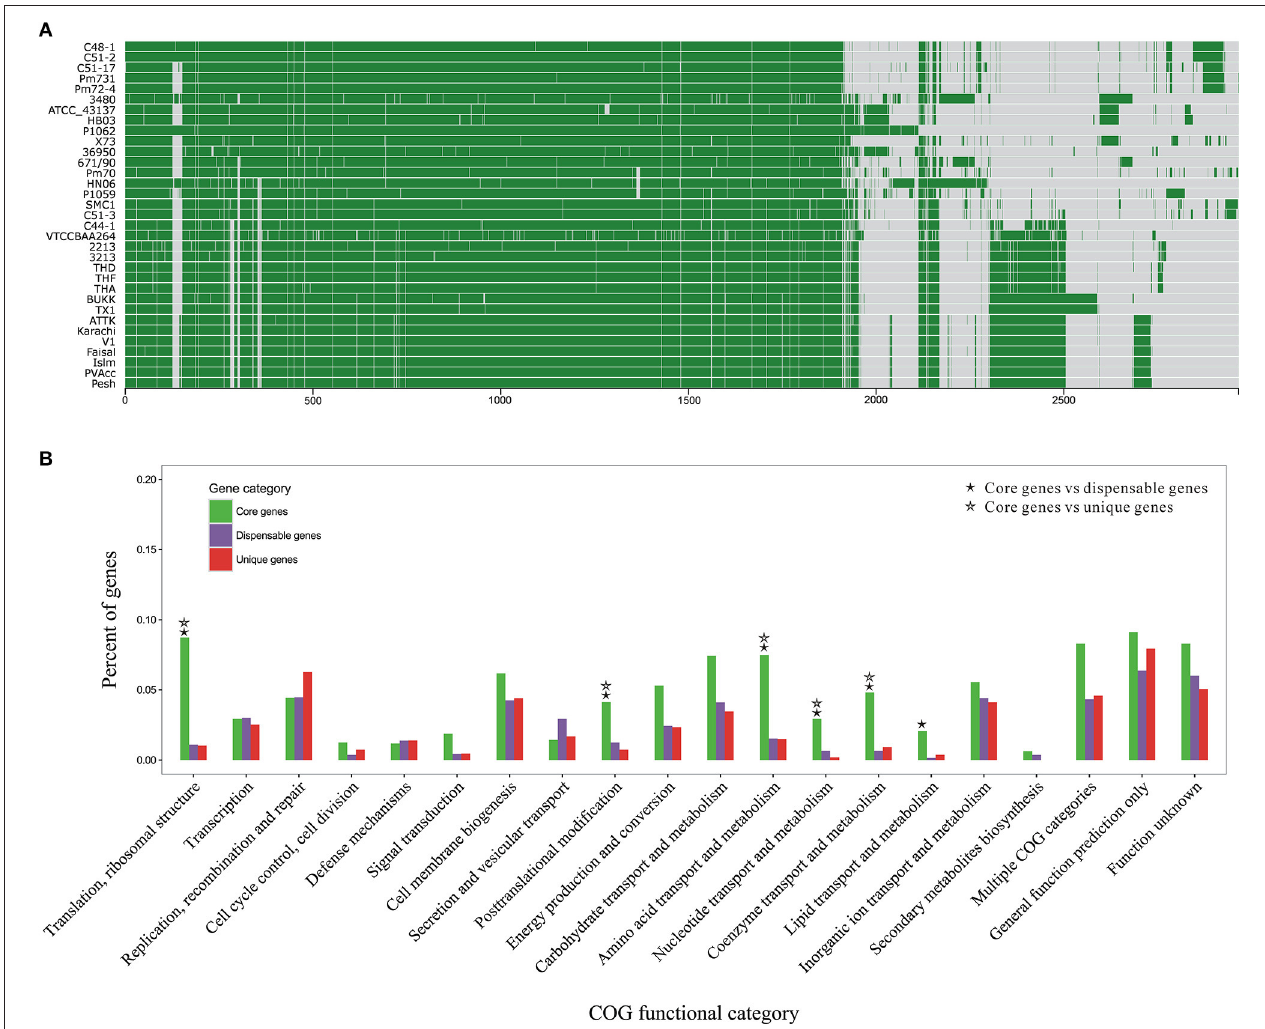
FIGURE 3 | Pan-genome structure and function of P. multocida . (A) A pan-genome map containing 2,966 OG clusters in all P. multocida genomes detected by Proteinortho (Lechner et al., 2011). Each block strands for a gene: green for presence and gray for absence. (B) COG-based binning of core genes, dispensable genes, and strain-specific genes. The abscissa denotes different COG functional categories. The ordinate denotes the proportion of genes in each COG category and details are summarized in Table S3. Two COG functional categories (“RNA processing and modification” and “Cell motility”) including only one OG are not displayed, as well as the genes encoding proteins without homologs in the COG collection. Significant enrichment of gene occurrence in the individual category is marked by asterisks (FDR < 0.001; Chi-square test).